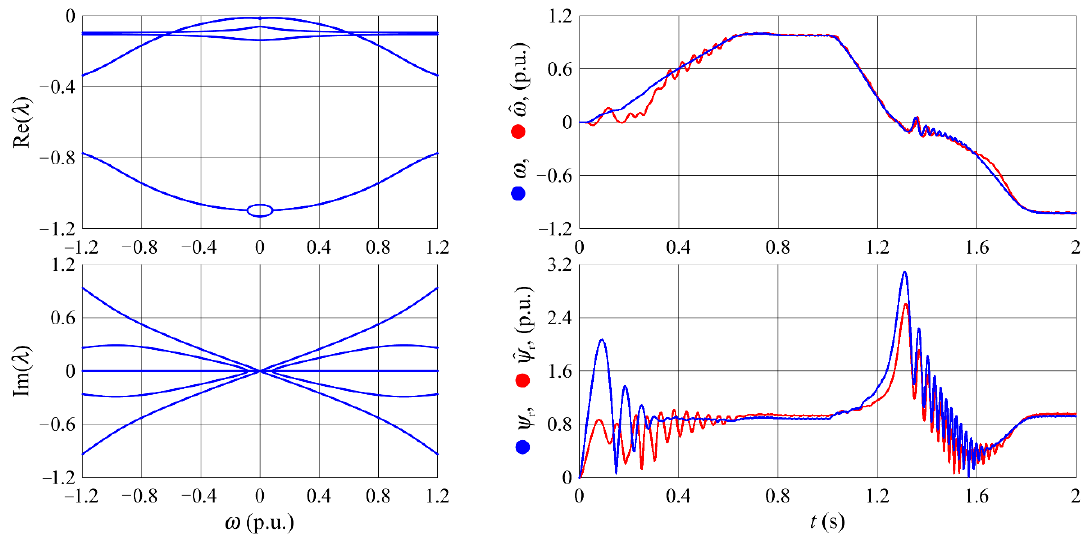
Figure 10. The eigenvalues and simulation results obtained for the observer with one ( v = 1) additional integrator.